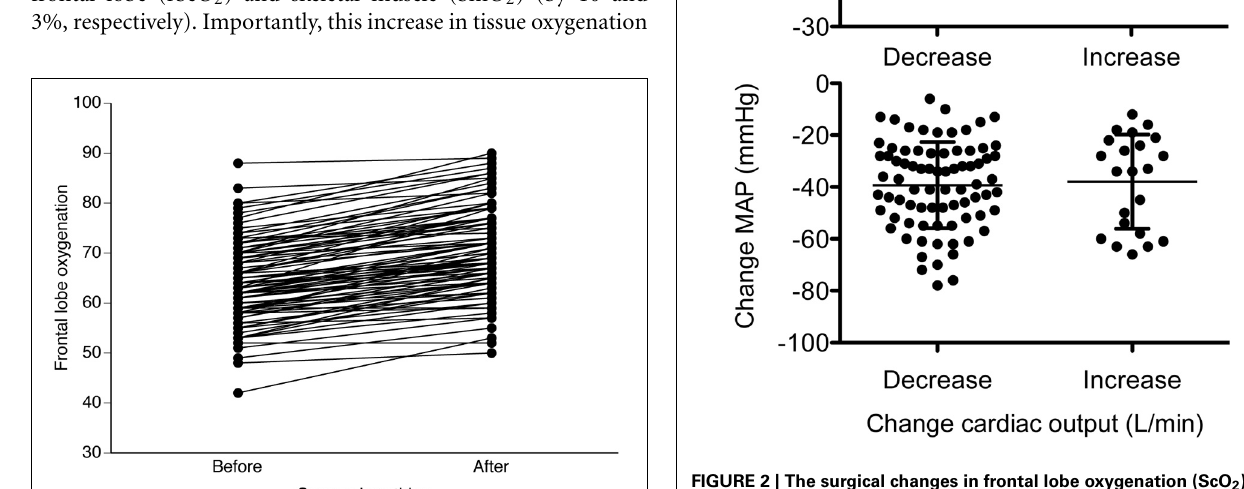
Table 1 | Cardiovascular and blood gas variables for vascular surgical patients. Before anesthesia During anesthesia Induction Intubation Surgery